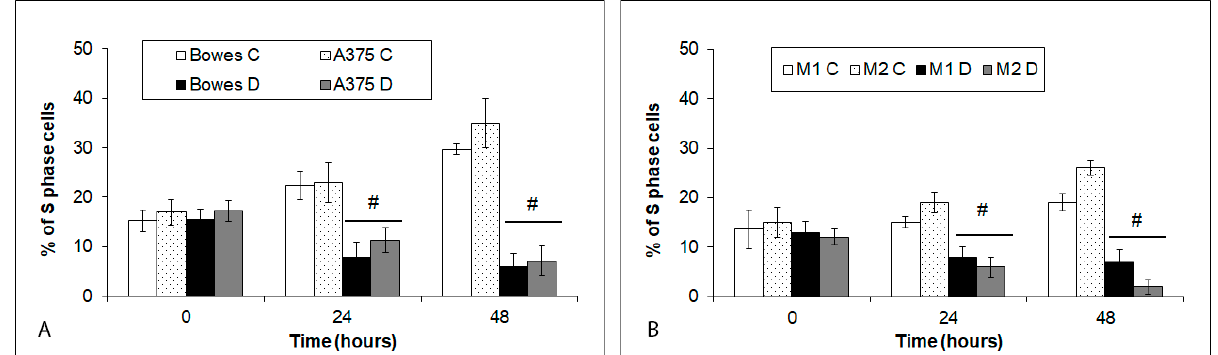
Figure 4. The S-phase fraction of human melanoma cells. ( A ) Bowes and A375 cell lines and ( B ) explant cultures M1 (low free zinc) and M2 (high free zinc) were exposed to 25 µM TPEN and proportions of their cells in S phase were determined with EdU assay. Values represent means ± SD of at least three experiments. p < 0.05 # Significantly lower than control cells at the same treatment interval with a one-way-Anova test and Dunnett’s post test for multiple